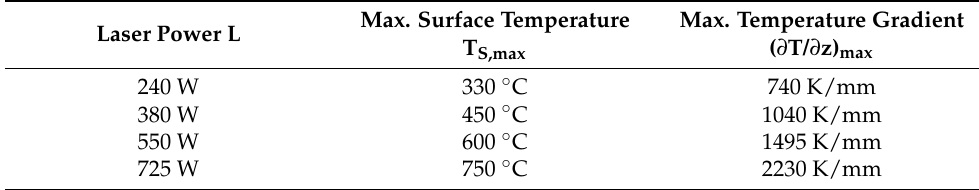
Table 3. Maximum temperature gradient and surface temperature for all laser power. Laser Power